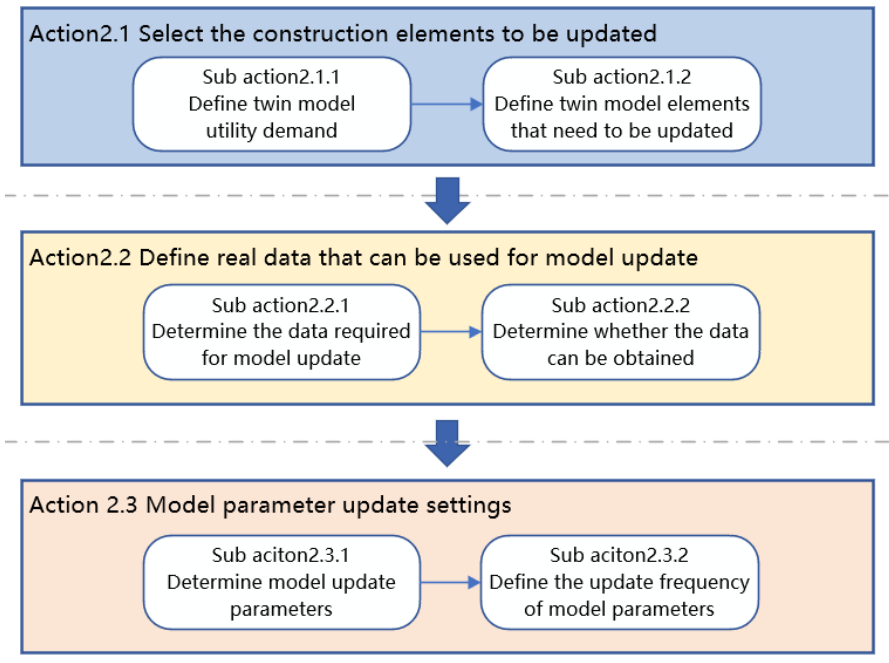
Figure 4. Actions and sub-actions of phase